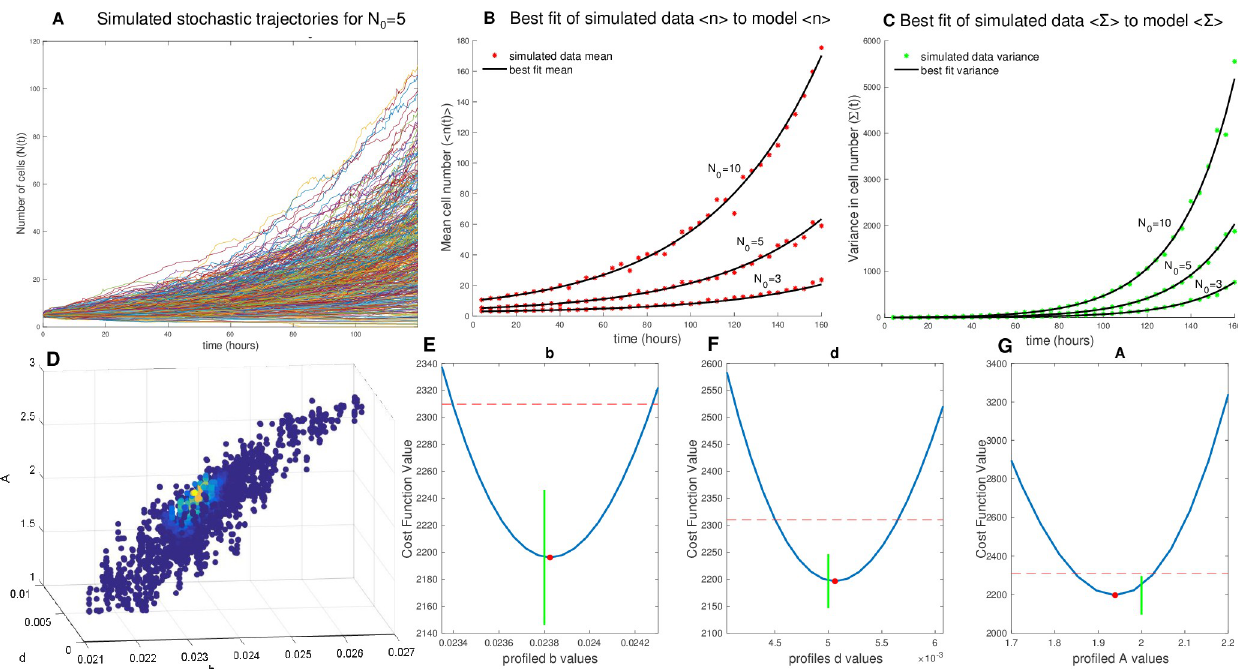
Fig 5. Fit to mean and variance from simulated stochastic data set. (A) Example of stochastic growth model output from 5,000 simulated cell-number trajectories with initial condition of N 0 = 5 and a birth rate of b = 0.0238, death rate of d = 0.005, and an Allee threshold A = 2, revealing the expected variability in growth dynamics apparent at low initial numbers. (B) From the simulated stochastic trajectories, we sample time uniformly and measure the mean cell number at each time point for N 0 = 3, 5, and 10. (C) Again from the simulated stochastic trajectories, we sample time uniformly and measure the variance in cell number at each time point for N 0 = 3, 5, and 10 (D) Display of parameter space searched, with parameter sets of b , d , and A colored by likelihood, indicating the framework converges on the true parameters. (E) Profile likelihood analysis of birth rate parameter estimate (red dot) of b = 0.0238 [0.02340–0.02425] with true b = 0.0238 (green line). (F) Profile likelihood analysis of death rate parameter estimate (red dot) d = 0.0051 [0.00461–0.00563] with true d = 0.005 (green line). (G) Profile likelihood analysis of Allee threshold parameter estimate (red dot) of A = 1.9393 [1.853–2.026] with true A = 2 (green line). The data and code used to generate this figure can be found at https://github.com/brocklab/Johnson-AlleeGrowthModel.git.